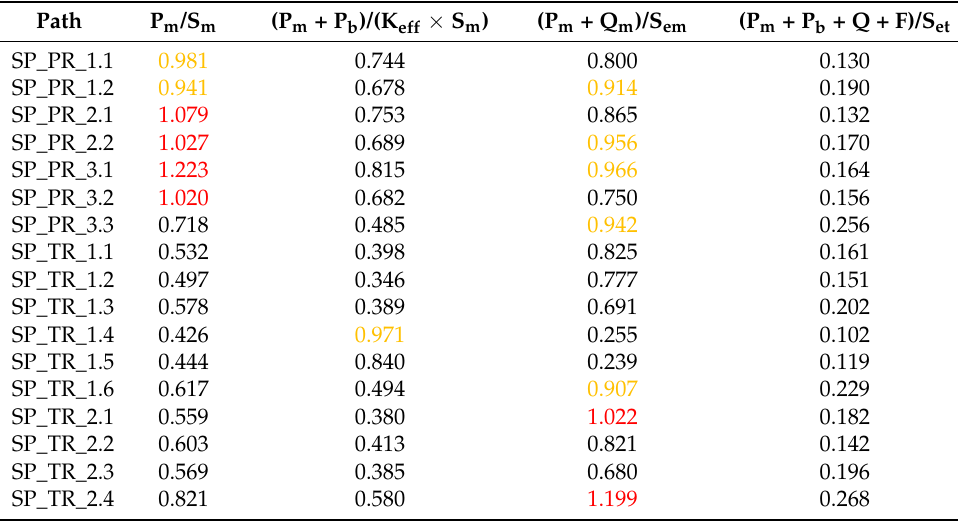
Table 9. RCC-MRx Level D criteria verification within SPs